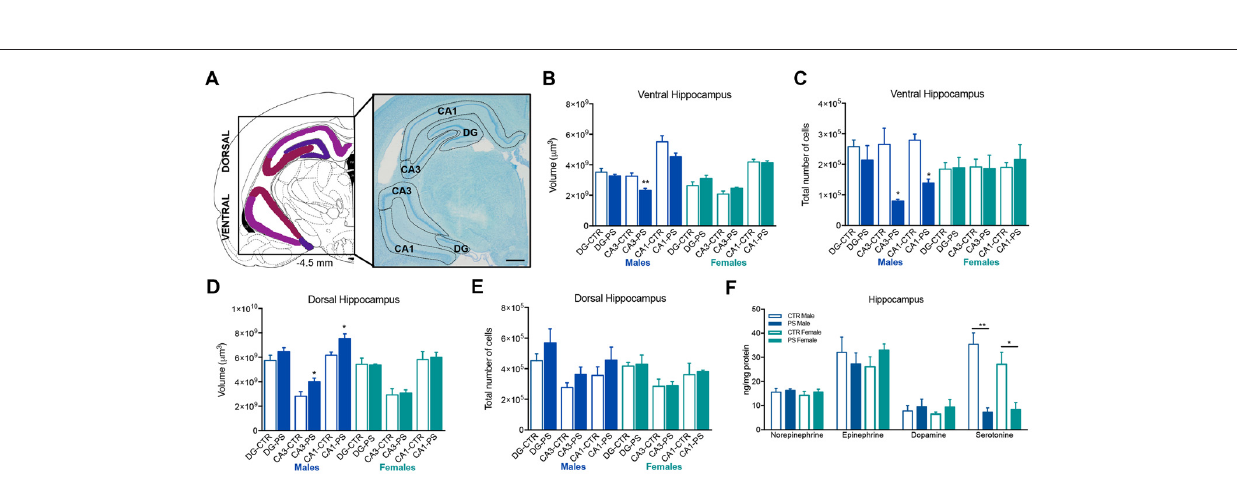
FIGURE 5 | Exposure to prenatal mild stress alters the structure and neurochemical content of the hippocampus. (A) Representative image of the ventral and dorsal hippocampus anatomy, using a methacrylate coronal section of a rat’s brain; numbers represent distance to Bregma; scale bar = 1 mm. (B) Male PS animals showed a significant reduction in the volume of the CA3 sub-region of the ventral hippocampus, with no significant differences in other sub-divisions of this brain region in comparison with male CTR rats; female PS rats did not show any significant difference in comparison with CTR (rats n PS males = 5, n CTR males = 4, n PS females = 5, n CTR females = 4). (C) Male PS rats also presented a reduced number of cells in CA1 and CA3 sub-regions of the ventral hippocampus, but not PS females (rats n PS males = 4, n CTR males = 4, n PS females = 4, n CTR females = 3). (D) Male PS animals showed a significant increase in the volume of the CA1 and CA3 sub-regions of the dorsal hippocampus, with no significant differences in dentate gyrus (DG) in comparison with male CTR rats; female PS rats did not show any significant difference in comparison with CTR female rats (n PS males = 6, n CTR males = 4, n PS females = 5, n CTR females = 4). (E) No differences were observed in the total number of cells between PS and CTR groups in the dorsal hippocampus (n PS males = 6, n CTR males = 4, n PS females = 5, n CTR females = 4). (F) Hippocampal catecholamine profile showing a reduction in serotonin levels in both male and female PS groups in comparison with same-sex CTR rats; no major differences were found in other neurotransmitters (rats n PS males = 4, n CTR males = 4, n PS females = 4, n CTR females = 4). Error bars denote SEM. ∗ p < 0.05, ∗∗ p <